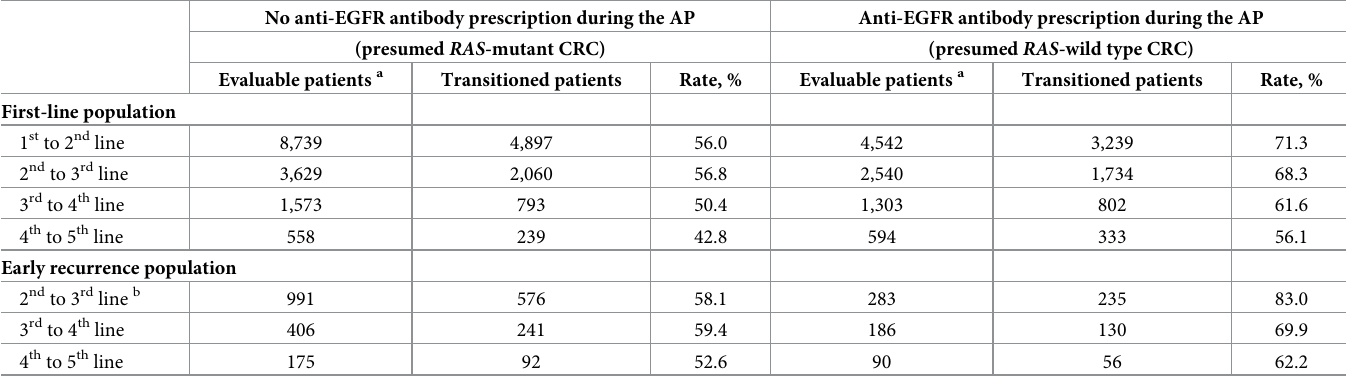
Table 1. Transition rates between lines of therapy for the first-line and early recurrence populations.